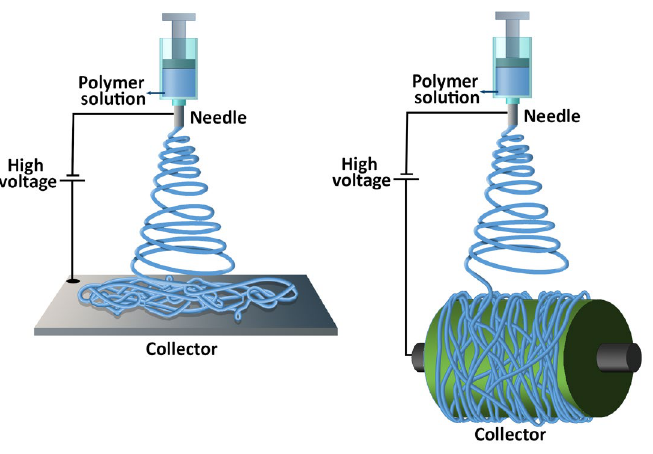
Figure 2. Schematic illustration of electrospinning methods employed for water-soluble polymers for the fabrication of air filters and face masks.